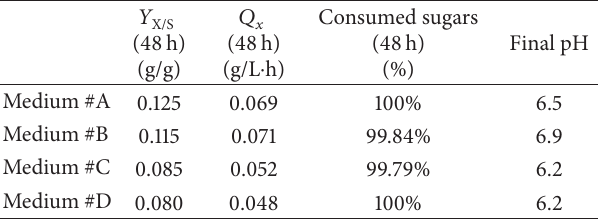
Figure 4: Ethanol yield ( Y P / S ) and productivity ( 𝑄 𝑝 ) after the fer- mentation of SBHH by S. shehatae UFMG-HM 52.2 using different nutritional medium (medium #A, #B, #C, and #D). Experiments were carried out in replicates and standard deviation is within 5%.